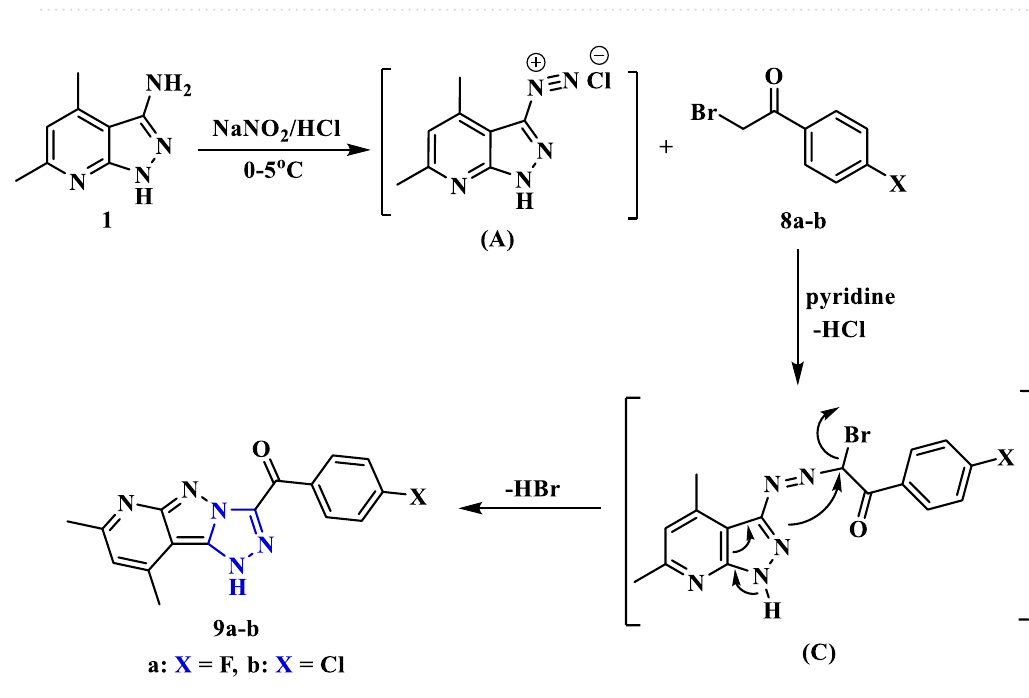
Figure 5. Synthesis of pyridopyrazolo-triazole derivatives 9a and 9b